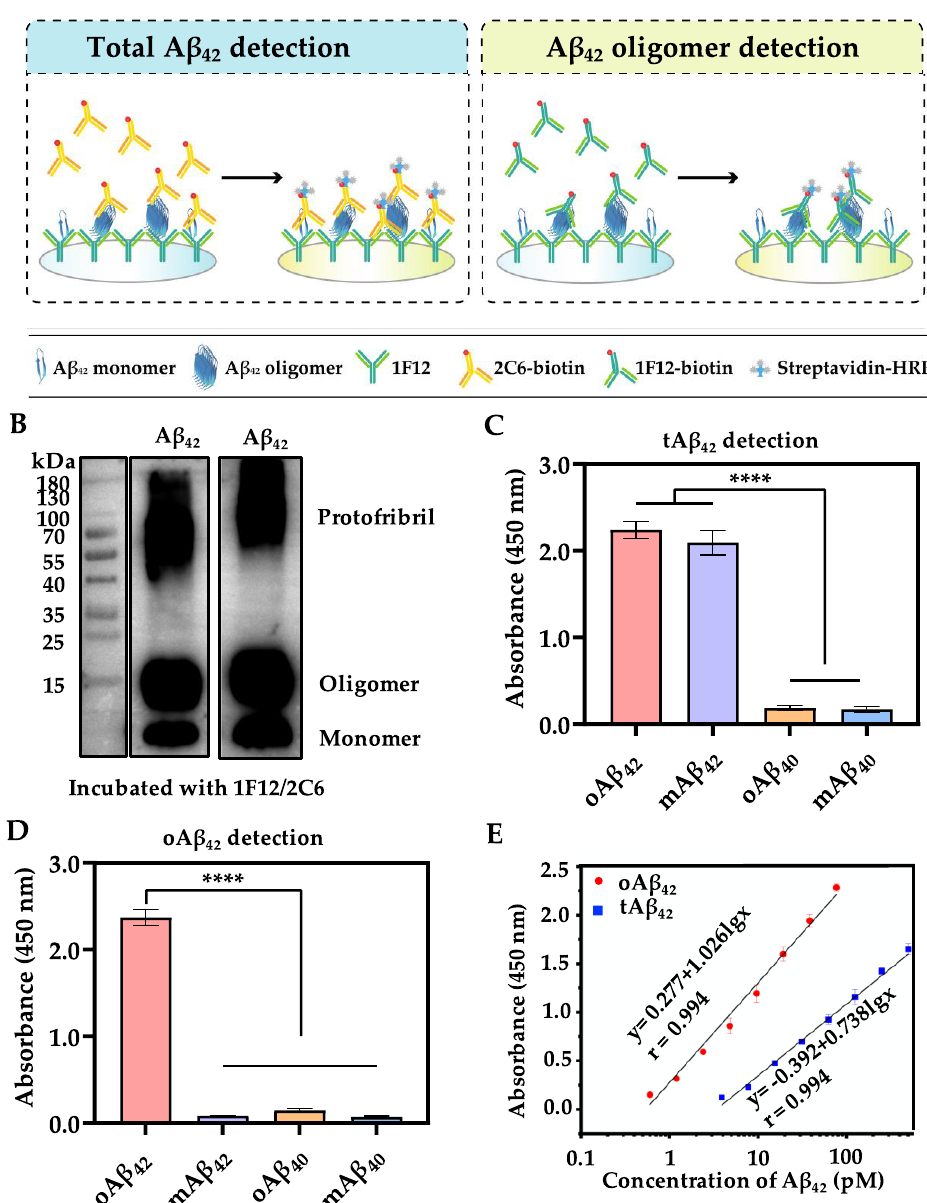
Figure 2. The performance of sandwich ELISA. ( A ) Principle of the proposed sandwich ELISA for tA β 42 and oA β 42 detection. ( B ) Western blotting analysis of the prepared A β 42 species using antibody 1F12 or 2C6. The specificity assay in tA β 42 - ( C ) and oA β 42 - ( D ) sandwich ELISA. ( E ) The plotted linear curve of different oA β 42 and tA β 42 conformations. Data are presented as means ± SD, n = 3. One-way analysis of variance (ANOVA) was used for multigroup comparisons. Statistical significance is represented in the figures by **** p <